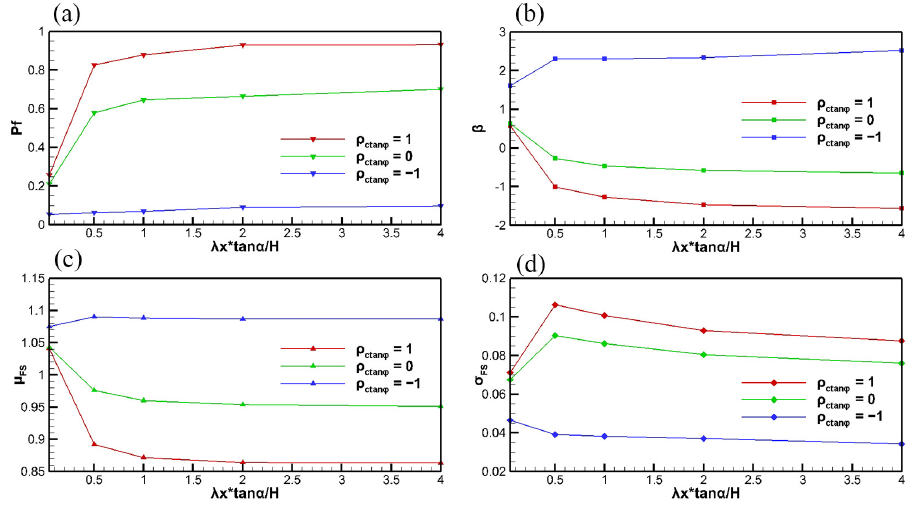
Figure 6. ( a – d ) are pf , β , μ FS and σ FS of FS obtained by MCS for different λ x and ρ c tan φ values.